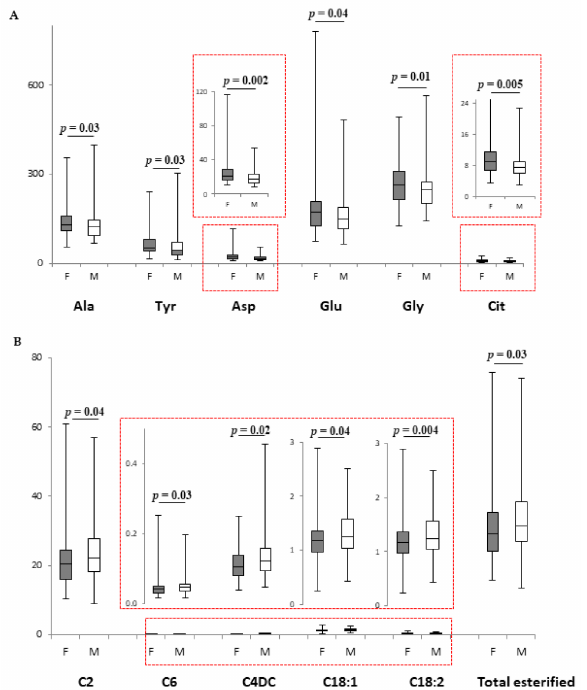
Figure 1. ( A ). Box plot of amino acids ( µ M) that displays the sex difference in female ( n = 66; grey bars) and male ( n = 81; white bars) VPI. ( B ). Box plot of acylcarnitines ( µ M) that displays the sex difference in female ( n = 71; grey bars) and male ( n = 93; white bars) MLPI. The horizontal line across the box represents the median, and the box comprises the first and the third quartiles. The vertical lines represent the minimum and the maximum values. Red boxes represent an enlargement of the box plots necessary due to the different scale on the y